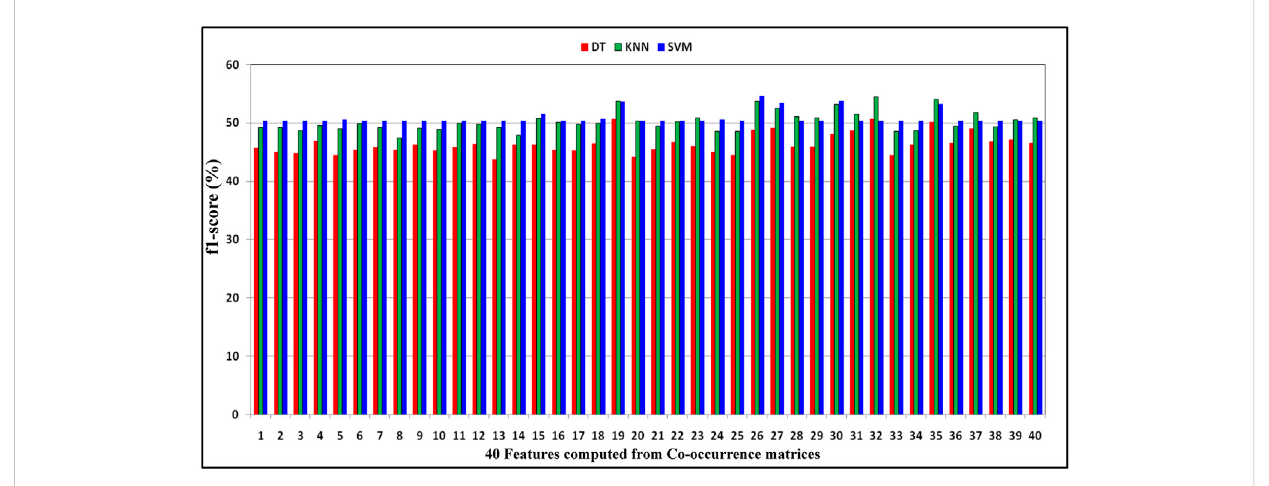
FIGURE 2 Demonstration of distribution of F1-score performance obtained by decision tree, KNN, and SVM classi fi ers with respect to the 40 features computed from co-occurrence matrices of DNA gene sequence S .